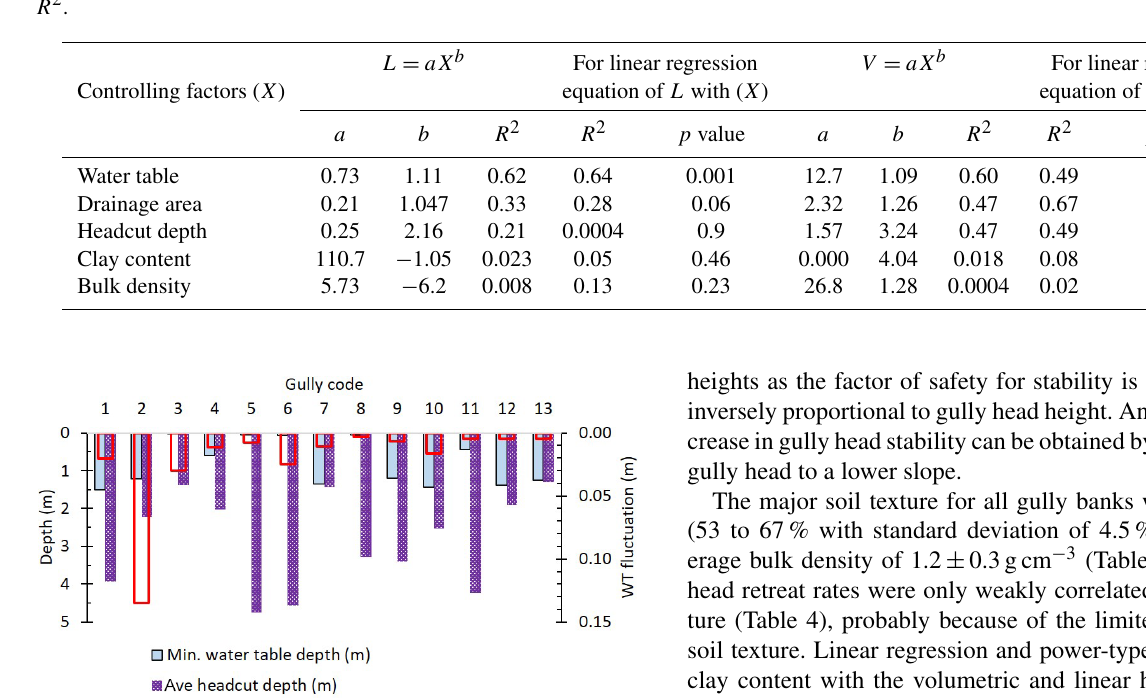
Table 4. Power-type and linear regression equations of the longitudinal headcut retreat, L , and the volumetric gully expansion, V , with the controlling factors, X , listed in the first column: L or V = aX b . The goodness of the fit is represented by the coefficient of determination, R 2 .